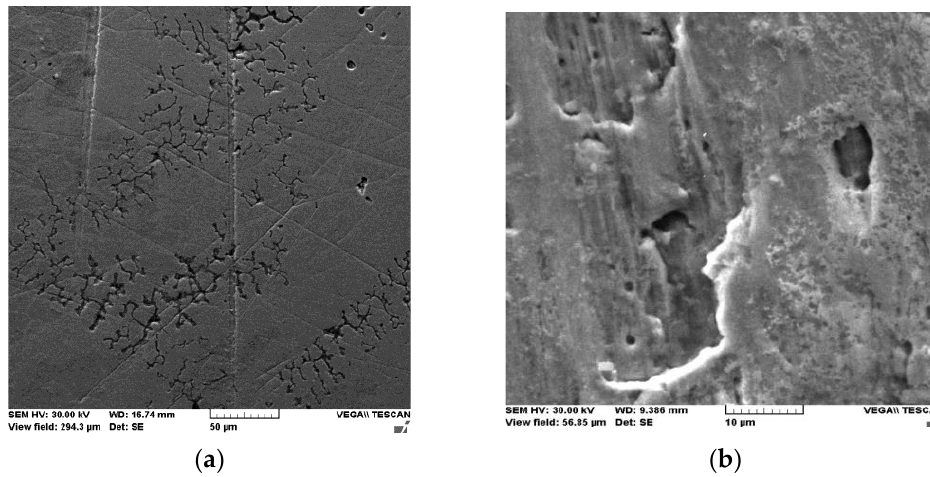
Figure 4. Metallographic appearance of the Ni-Cr surface before ( a ) and after ( b ) the occurrence of the corrosion process. (WD — working distance — the distance between sample surface and the lower end of the pole piece where the electrons are coming from; HV — accelerated energy; SE — detector)